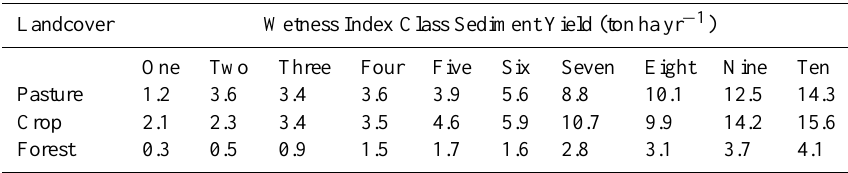
Table 5. Annual predicted sediment yield for each wetness index class (basin average) and for the pasture, crop, and forest land covers. Wetness Index one produces the lowest runoff; wetness class ten produces the most